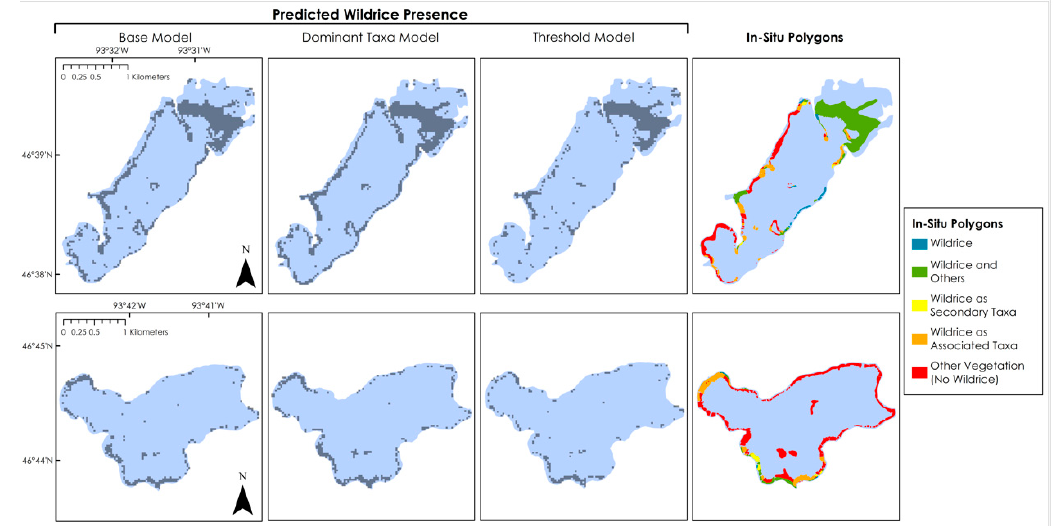
Figure 6. Comparison of predicted wildrice presence between all three models across Gun Lake (top row) and Esquagamah Lake (bottom row). Gun Lake is representative of trends observed across lakes with high cover of wildrice while Esquagamah Lake highlights trends across lakes with low wildrice cover; these examples cover the spectrum of predictive patterns. Each set of model predictions shown in gray (columns one through three) were compared to the in-situ data collected across the two lakes which represent the extent of wildrice presence and absence surveyed in 2015 (column four).